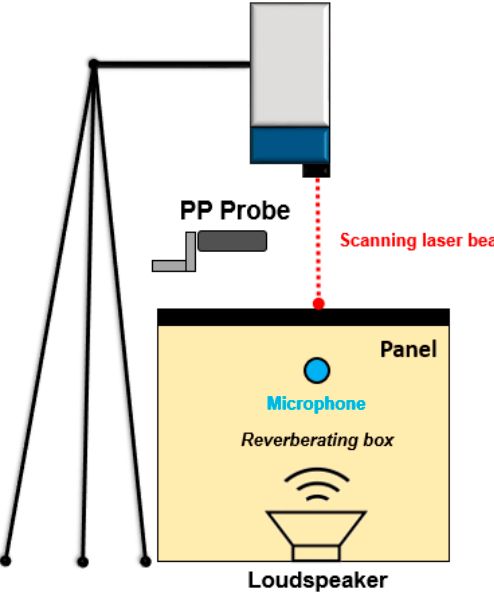
Figure 5. Vibro-acoustic characterization test setup.